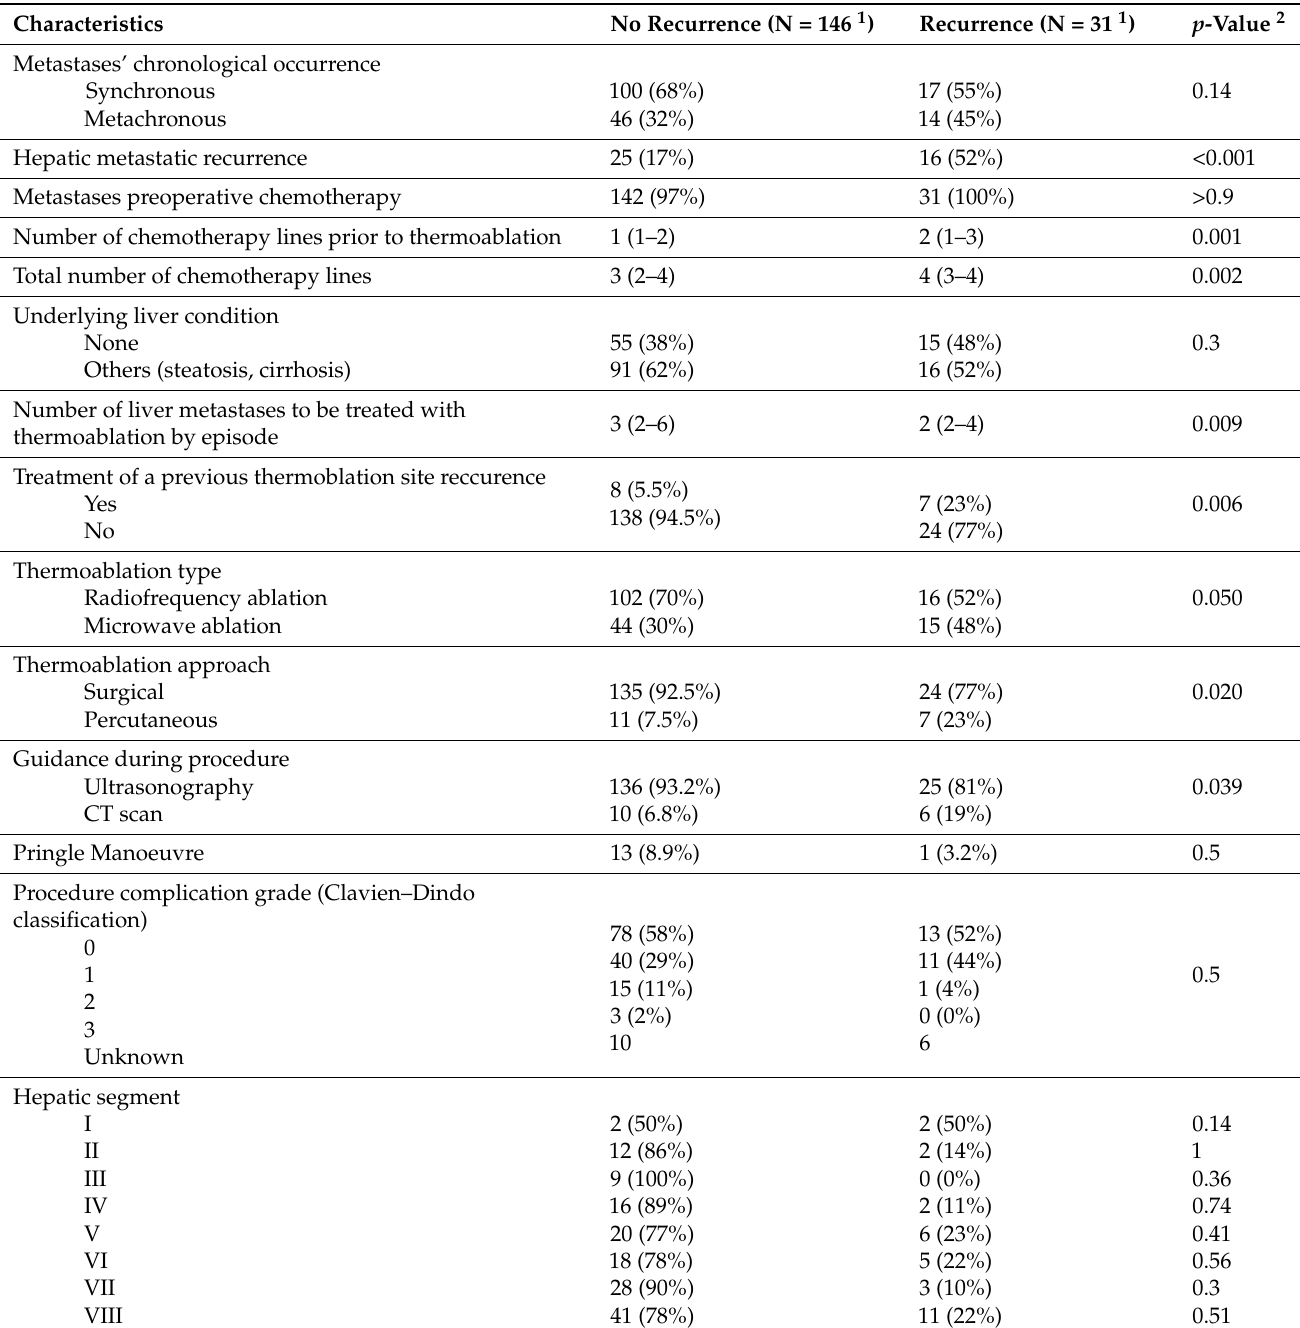
Table 3. Comparison of lesion characteristics by recurrence